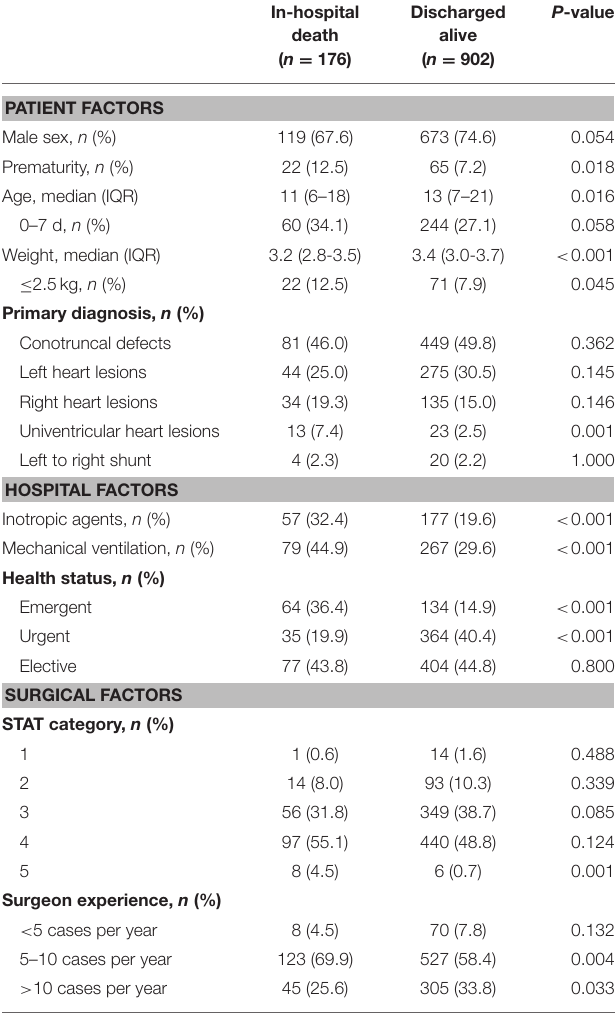
TABLE 1 | Preoperative characteristics for 1,078 study